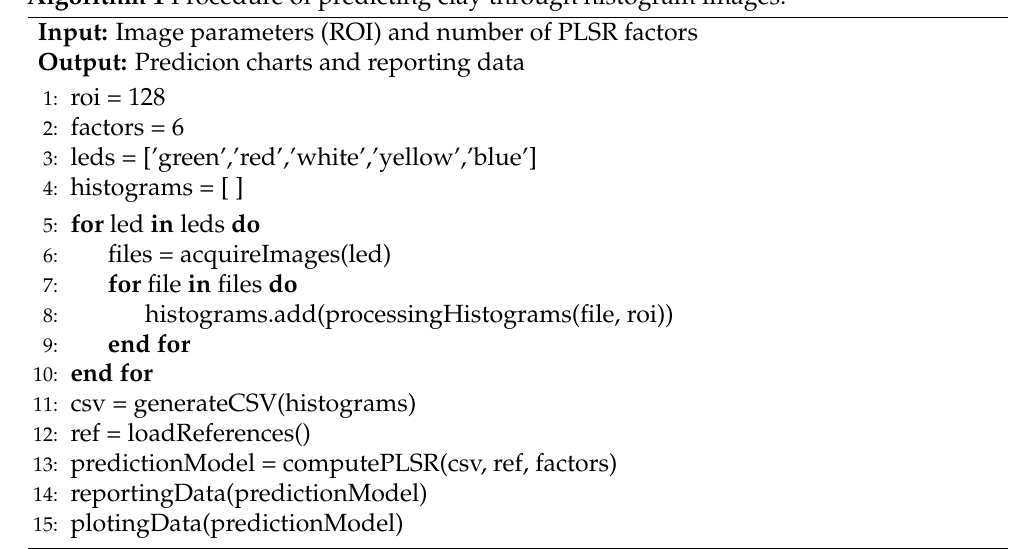
Algorithm 1 Procedure of predicting clay through histogram images.